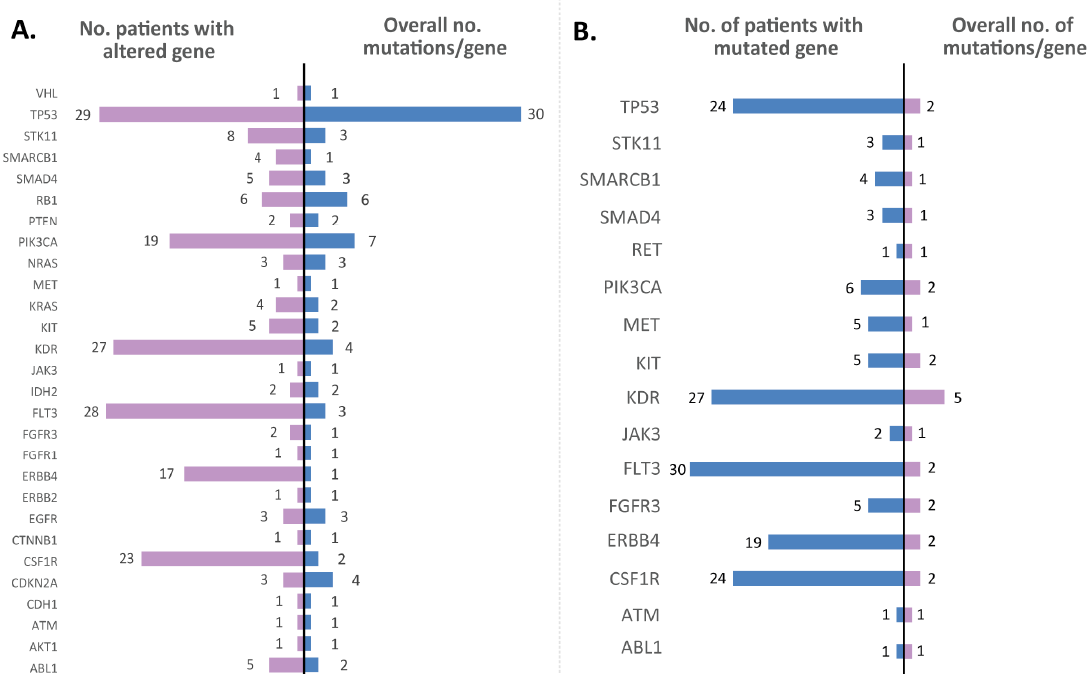
Figure 5. Bar graph representing the number of different mutations identified in each gene (left) and the number of patients in which at least one variant was detected for each gene (right) in tumor tissue samples ( A ) and whole blood samples ( B ).